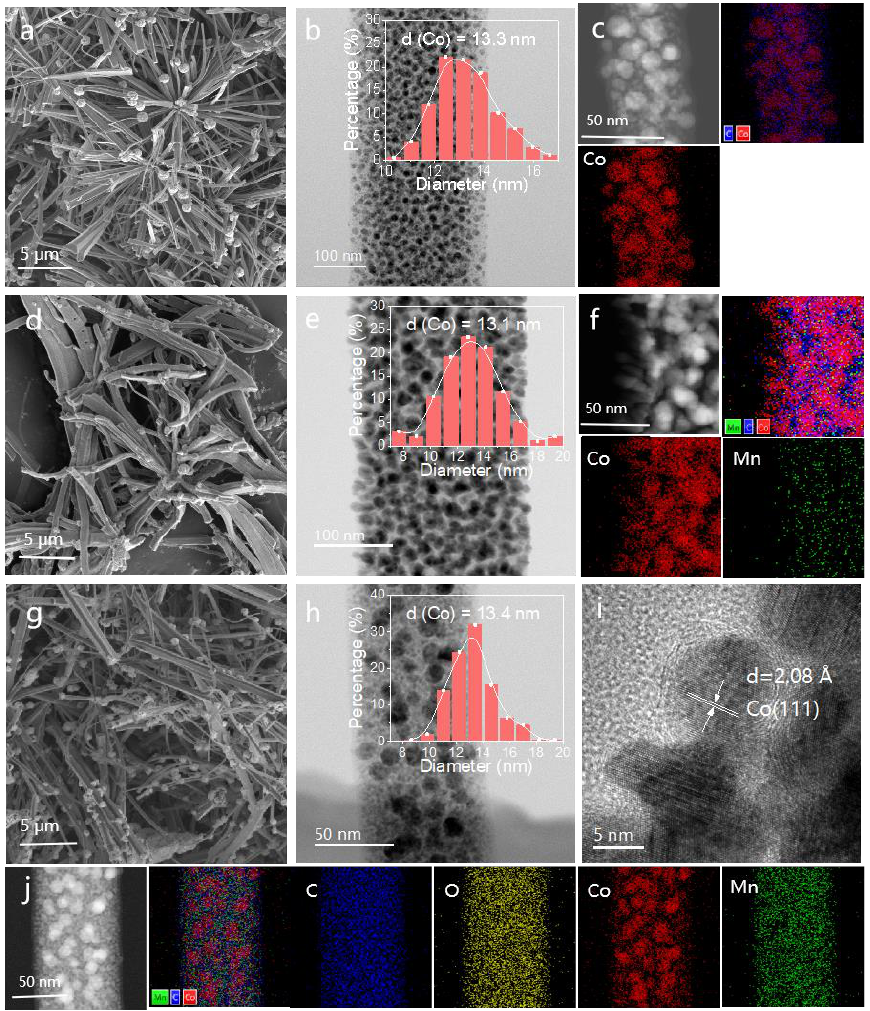
Figure 4. Scanning electron microscopy (SEM) images: ( a ) Co@C, ( d ) 20Co1Mn@C, ( g ) 2Co1Mn@C. Transmission electron microscopy (TEM) images: ( b ) Co@C, ( e ) 20Co1Mn@C, ( h ) 2Co1Mn@C. Insets in ( b , e , h ) show the Co 0 particle size distribution. ( i ) High-resolution transmission electron microscopy (HRTEM) image for 2Co1Mn@C. ( c , f , j ) HAADF-STEM images and corresponding EDS mapping images of Co and MnO nanocrystals homogeneously embedded in porous carbon matrix.